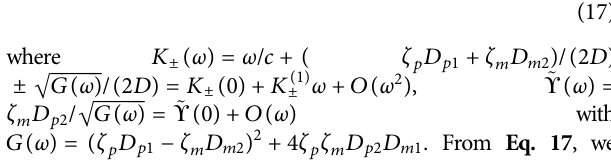
Frontiers in Physics |